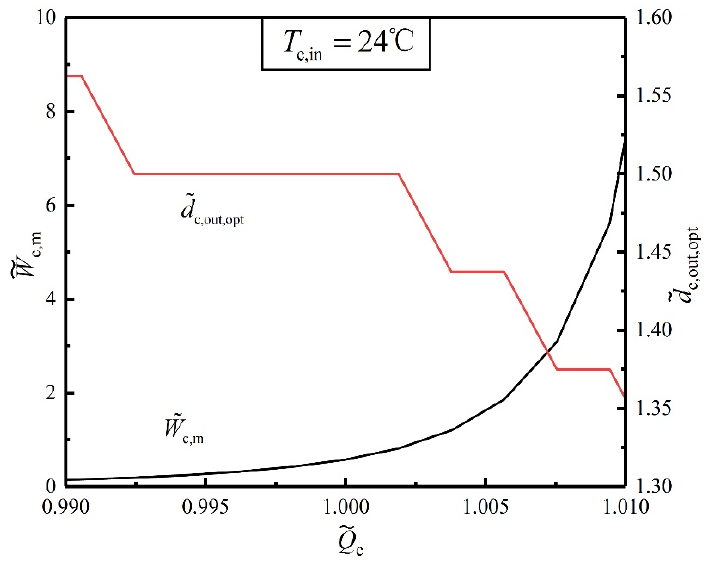
Figure 9. Influences of (cid:101) Q c on the (cid:101) W c , m and (cid:101) d c , out , opt . Energies 2021 , 14 x 10 of 17